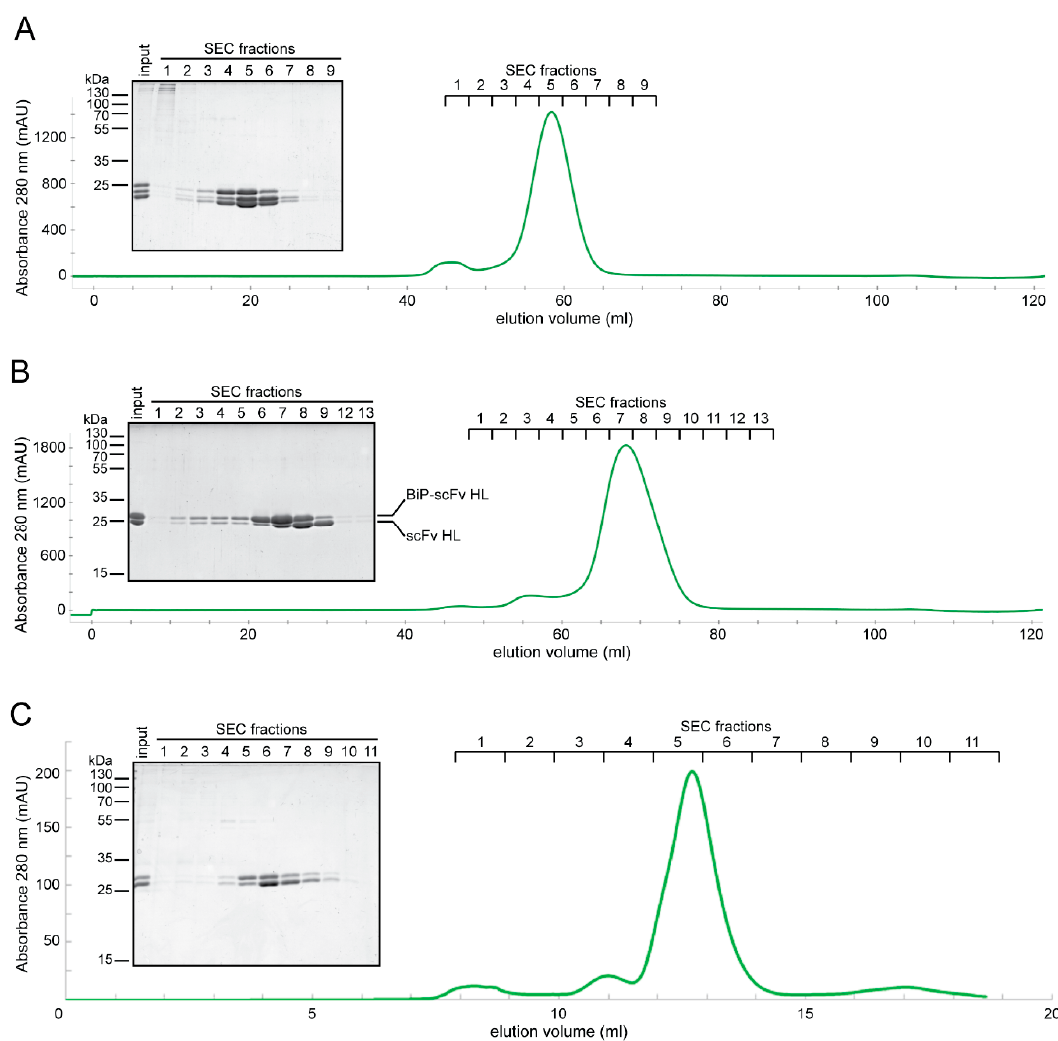
Figure 3. Purification of 5D3 fragments overexpressed in insect cells. Secreted variants were purified by the combination of Streptactin affinity chromatography and size exclusion chromatography (SEC). CBB-stained SDS-PAGE gels and SEC elution profiles are shown for Fab ( A ), scFv HL ( B ) and scFv LH ( C ) variants.